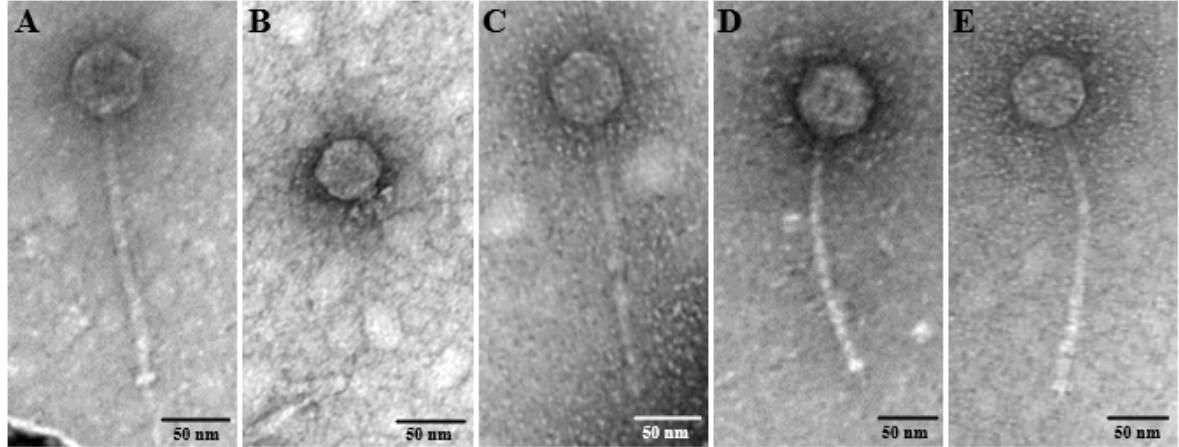
Figure 1. TEM image of the bacteriophage’s virions ( A ) CUB_EF03, ( B ) CUB_EF04, ( C ) CUB_EF06, ( D ) CUB_EF10, and ( E ) CUB_EF14.